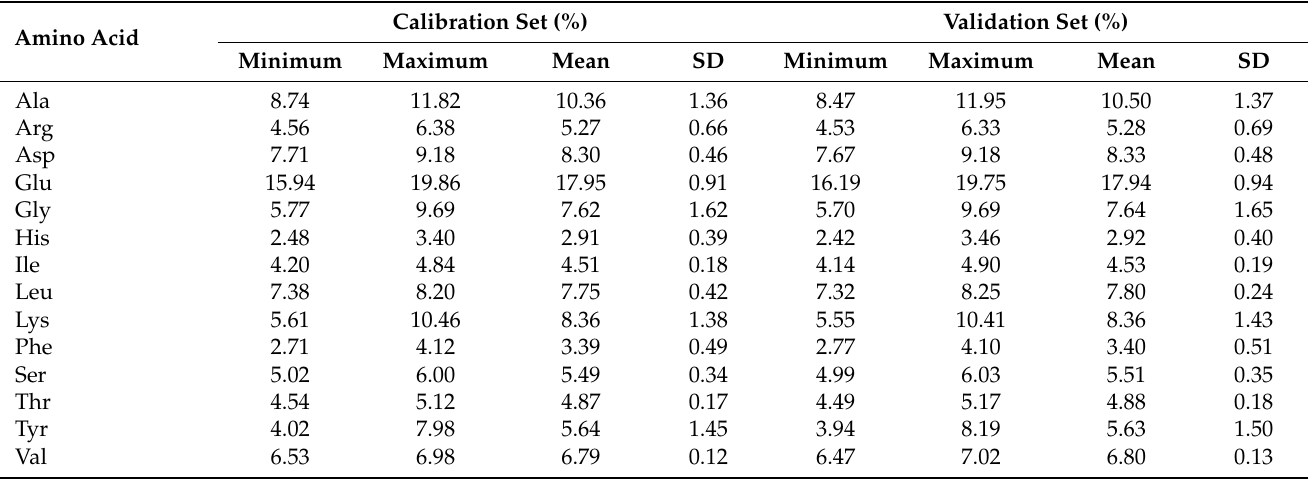
Table 2. Amino acid content of living Tenebrio molitor larvae (values given in % of dry weight) for calibration ( n = 80) and validation sets ( n = 40) analyzed by HPLC with OPA derivatization.